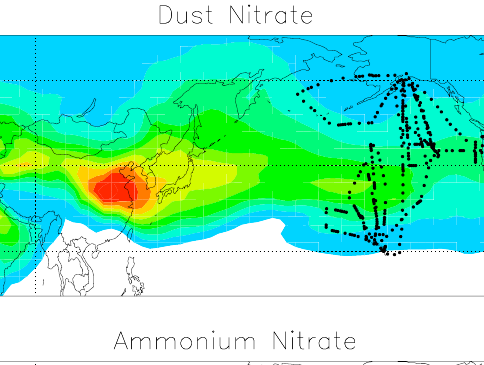
Fig. 5. Altitude profiles of observed (black) and simulated aerosol nitrate, HNO 3 (g), and dust alkalinity for the INTEX-B flights. Val- ues are medians in 1-km vertical bins. Profiles are shown for the standard simulation with no acid uptake (green), the standard sim- ulation with acid uptake (red), and a simulation with γ (HNO 3 ) in- creased by a factor of 10 from the values in Fig. 1 (yellow). Ob- served alkalinity is inferred from the anion deficit shown in Fig. 4.